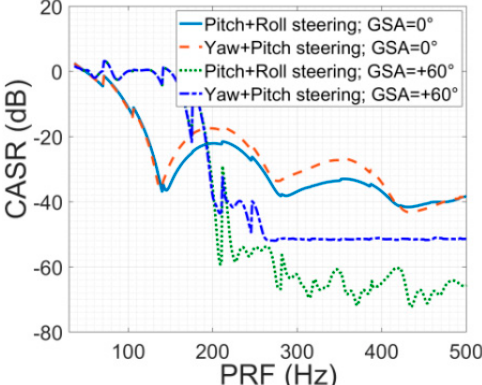
Figure 16. CASR and DT-CASR of Geo-SAR at a latitude argument of 23.4 ◦ . ( a ) Broadside, latitude argument of 23.4 ◦ . ( b ) 60 ◦ squint, latitude argument of 23.4 ◦ .